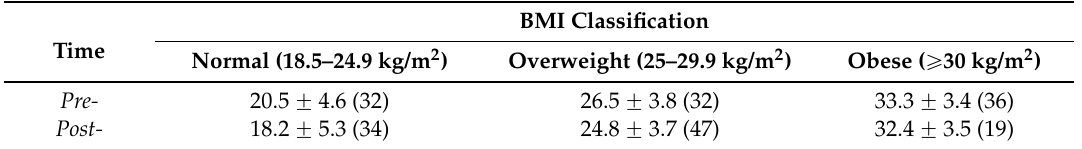
Table 1. Mean BF% according to BMI classification in submariners before and after a 3-month